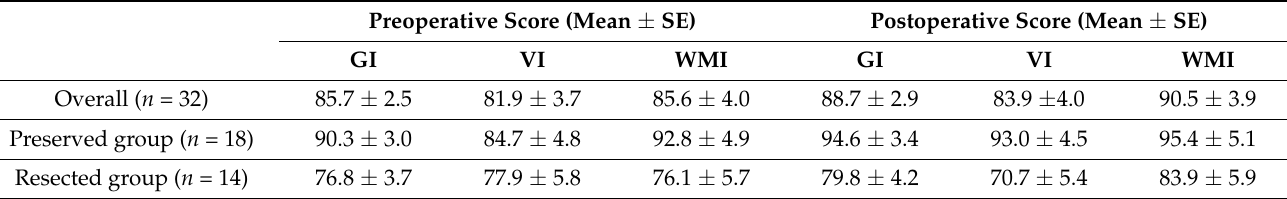
Figure 3. The Kaplan–Meier curve shows the seizure-free survival of patients in the Resected and Preserved groups. Table 3. Pre- and postoperative cognitive